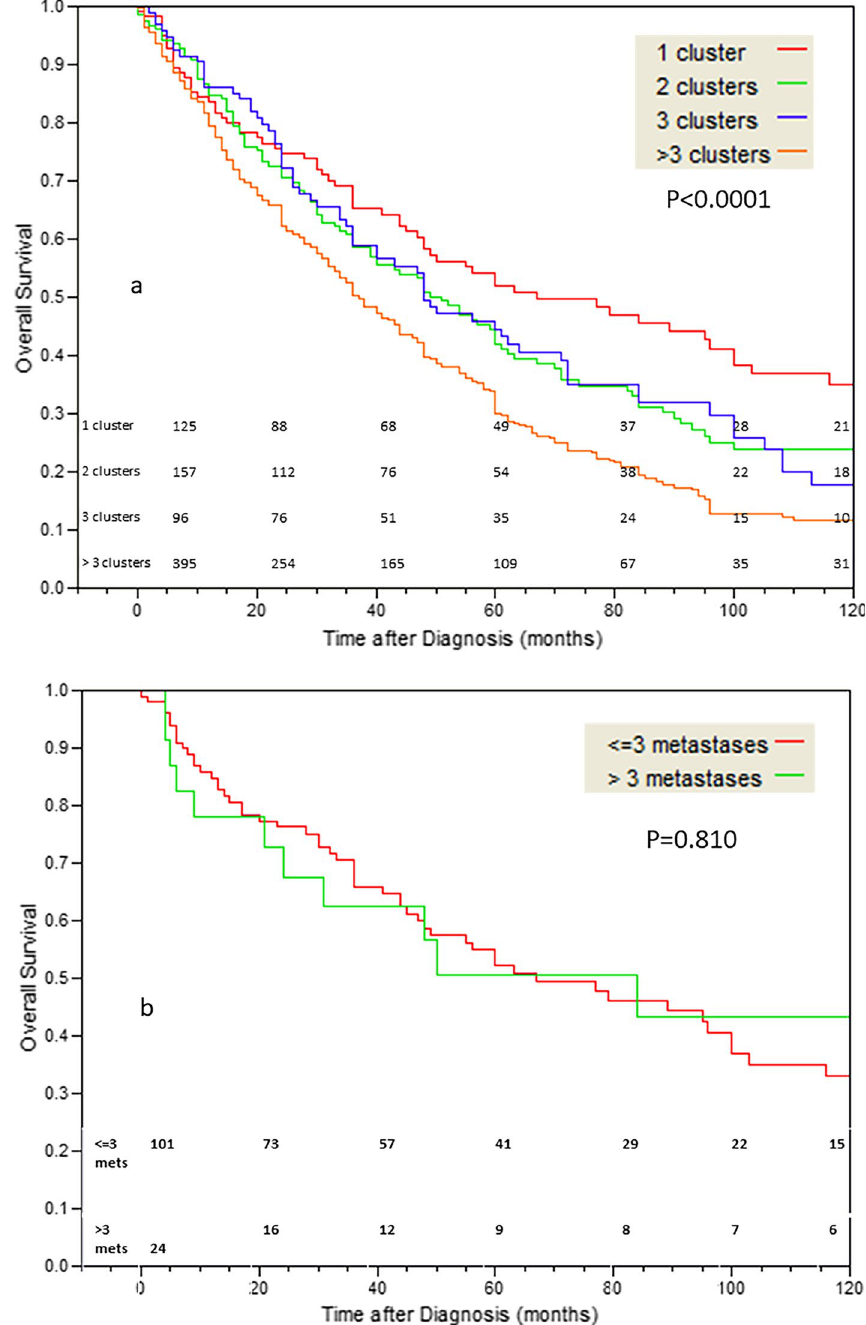
Fig. 2 a The effect of metasta- ses cluster number (clustering metastases with diameter difference of 1 mm or less) on OS. The cutoffs used are: 1, 2, 3, > 3 clusters (p < 0.0001). b The effect of metastases num- ber in patients with a single cluster of metastases compar- ing patients with < = 3 metas- tases to patients with > 3 metastases (4–41 metastases), on OS (p =